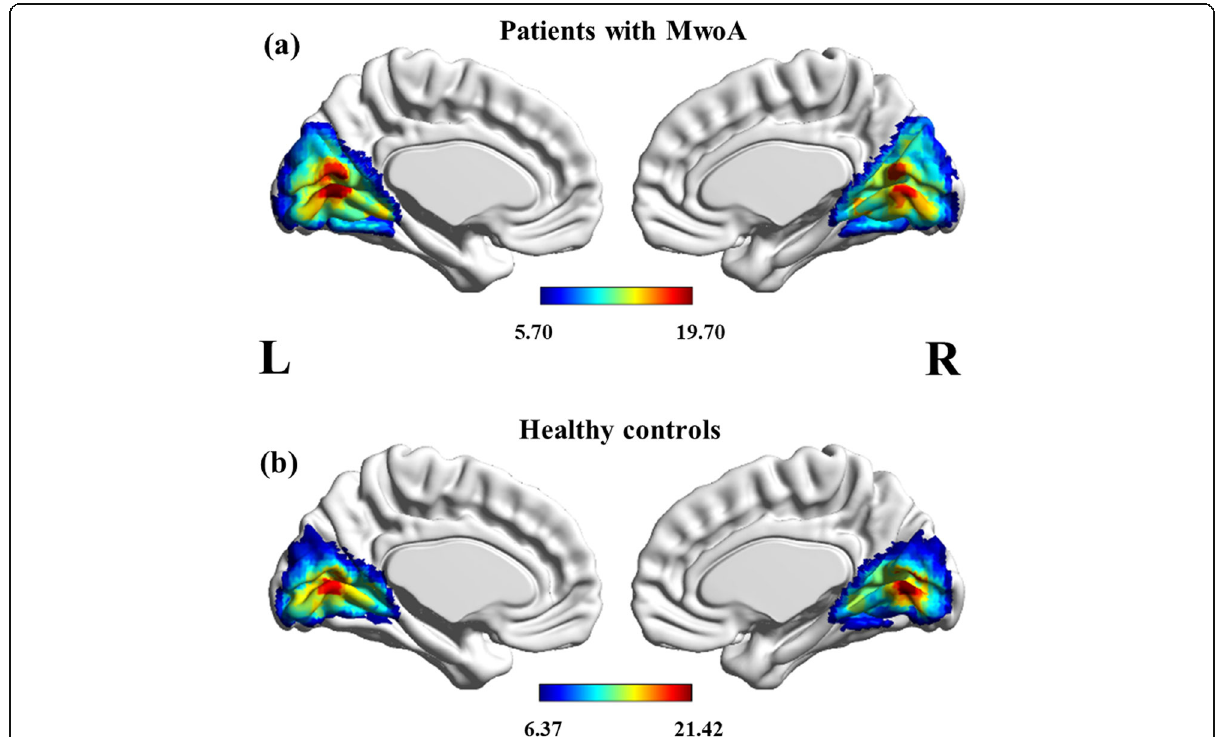
Fig. 1 Group-level visual network in patients with MwoA ( A ) and healthy controls ( B ). Statistical maps were overlaid on the inflated 3D brain surface from the ‘ Colin 27 ’ atlas. Significant thresholds were corrected using cluster-level family-wise error (FWE) correction and set at p < 0.05, cluster size > 30. MwoA: migraine without